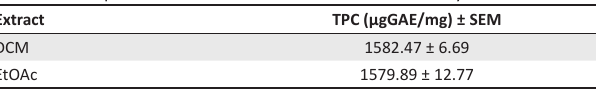
TABLE 5: Total phenolic contents of dichloromethane and ethyl acetate extracts.